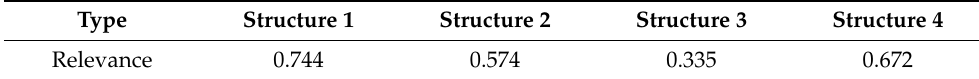
Table 21. Correlation of four typical structures calculated by the improved AHP